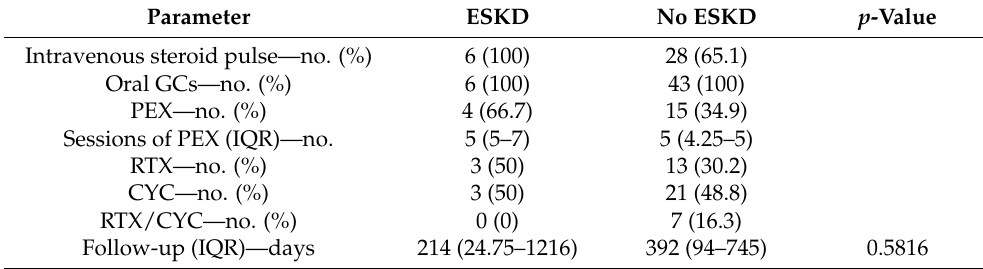
Table 4. The long-term renal outcome in ANCA